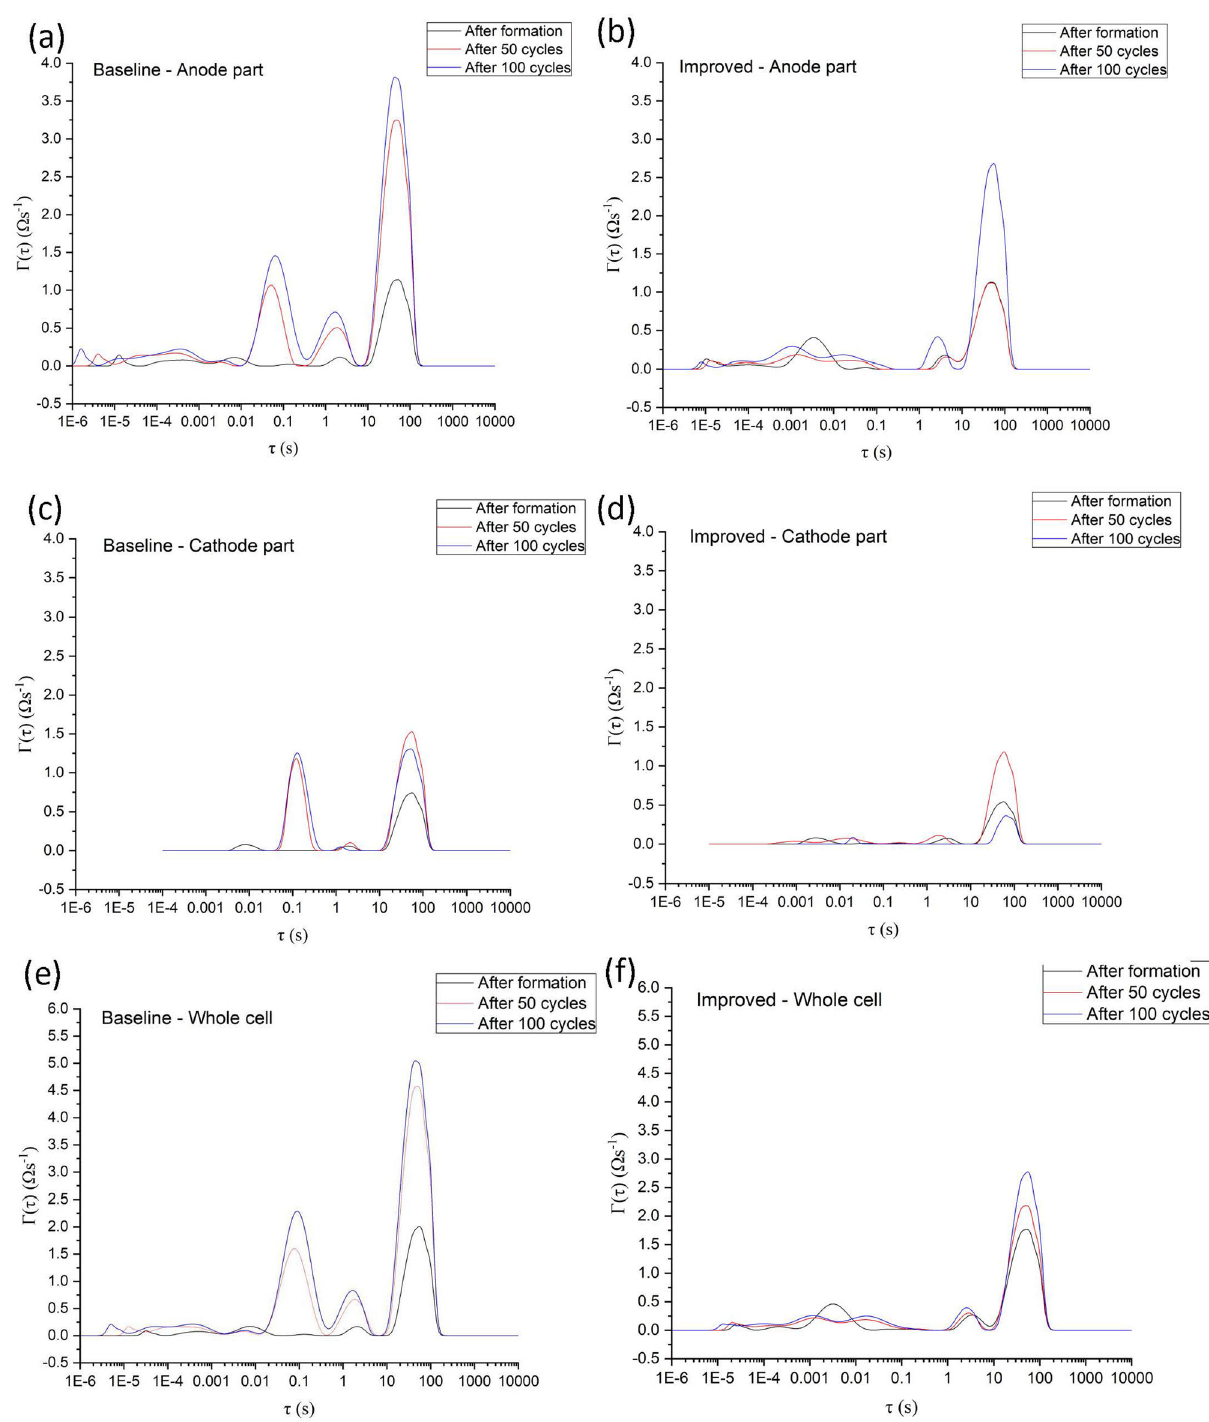
Fig. 8 DRT at different states of aging. a Baseline anode, b improved anode, c baseline cathode, d improved cathode, e baseline whole cell, f improved whole cell. (Reprinted from ref. 26 . Copyright © 2022, with permission from